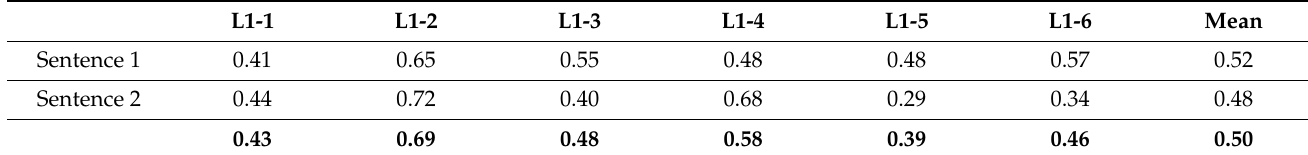
Table 10. Average deviations of group L1-TR from their own group means.